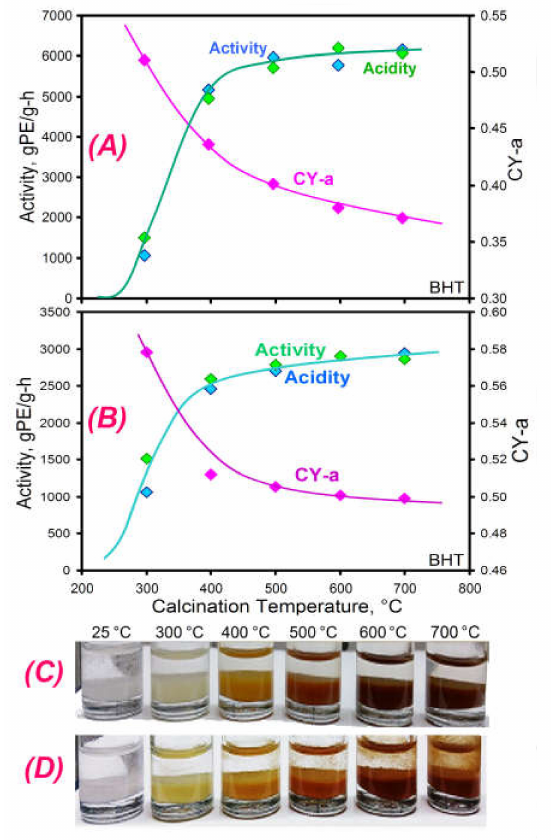
Figure 12. Activity, acidity and LCB (CY-a) from metallocene C supported on ( A ) fluorided silica- alumina, or ( B ) sulfated alumina, and colors ( C ) and ( D ) obtained respectively with BHT, all as a function of calcination